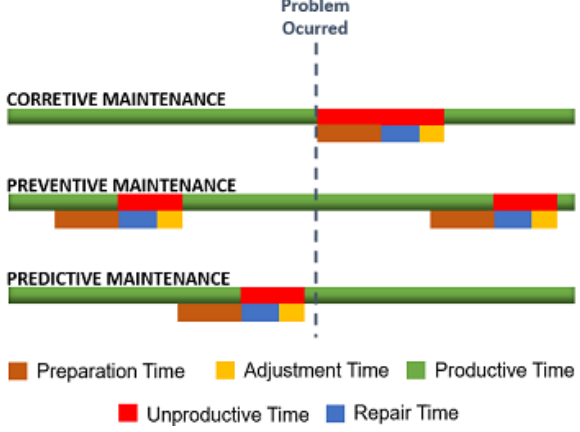
Figure 2. Types of maintenance.